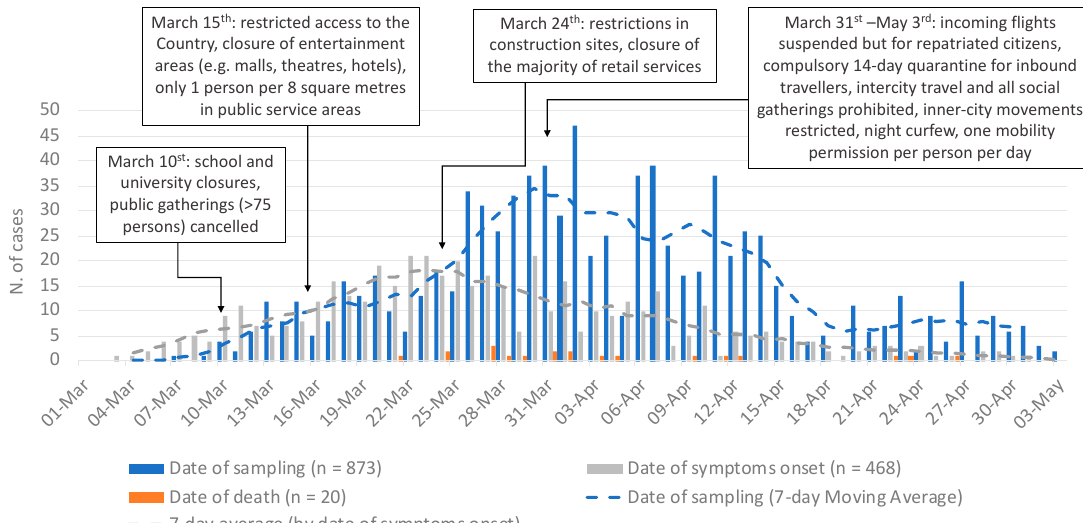
Figure 1. Number of laboratory-confirmed COVID-19-cases by date of sampling (blue), 7-day moving average by date of sampling (dash blue line), date of symptoms onset (gray), 7-day moving average by date of symptoms onset (dash gray line) and date of death (orange), and public health interventions implemented, Cyprus 1 March–3 May 2020.